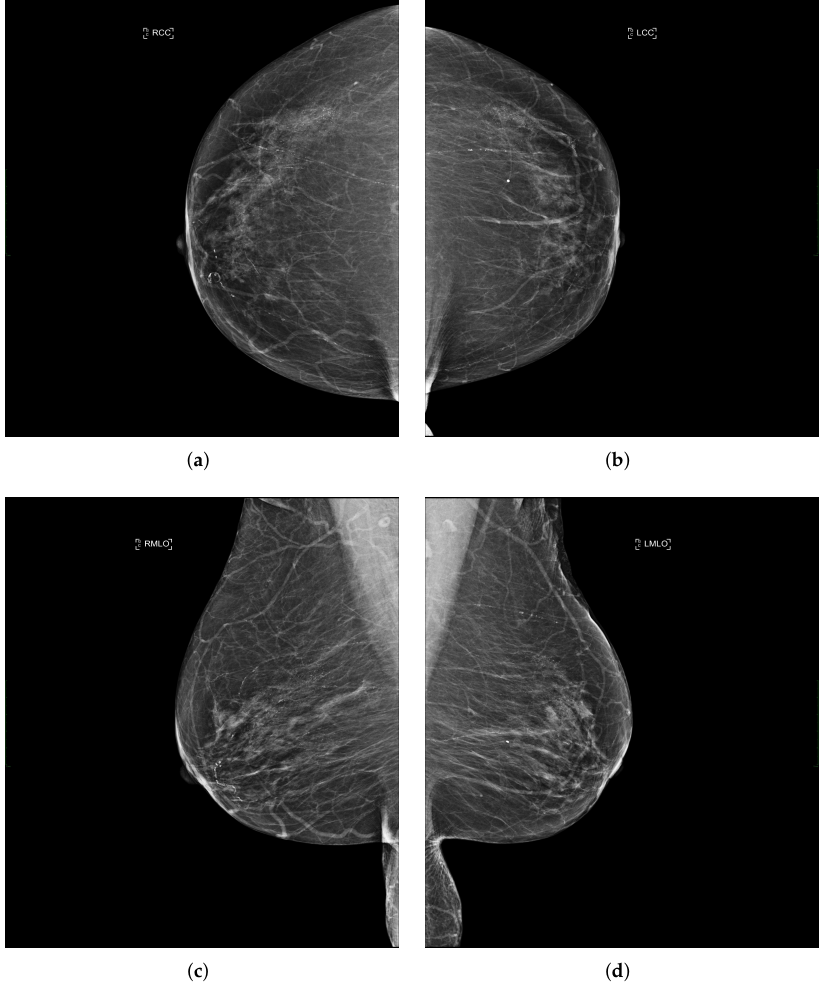
Figure 3. Example of a mammography study selected from the collected dataset showing the four standard views ( a – d ). ( a ) right cranio-caudal (R-CC); ( b ) left cranio-caudal (L-CC); ( c ) right mediolateral oblique (R-MLO); ( d ) left mediolateral oblique